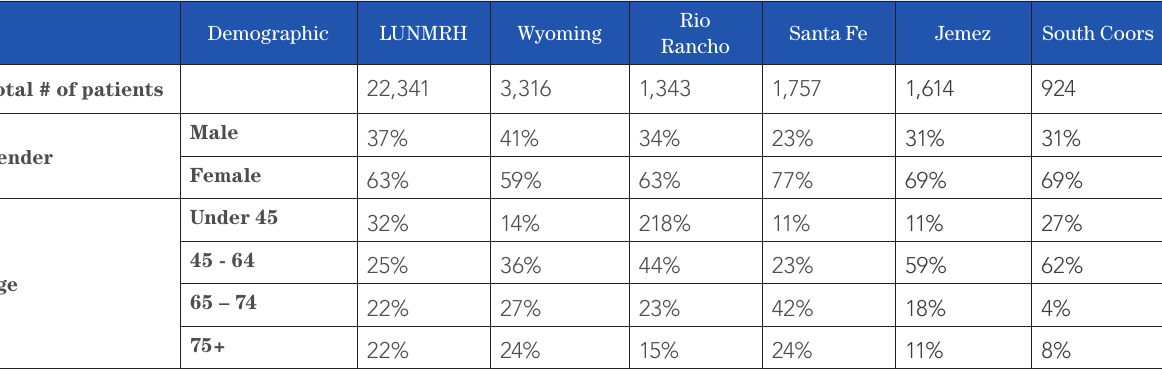
Table 7. The number of patients, the gender and the age of patients seen by location for 2018.